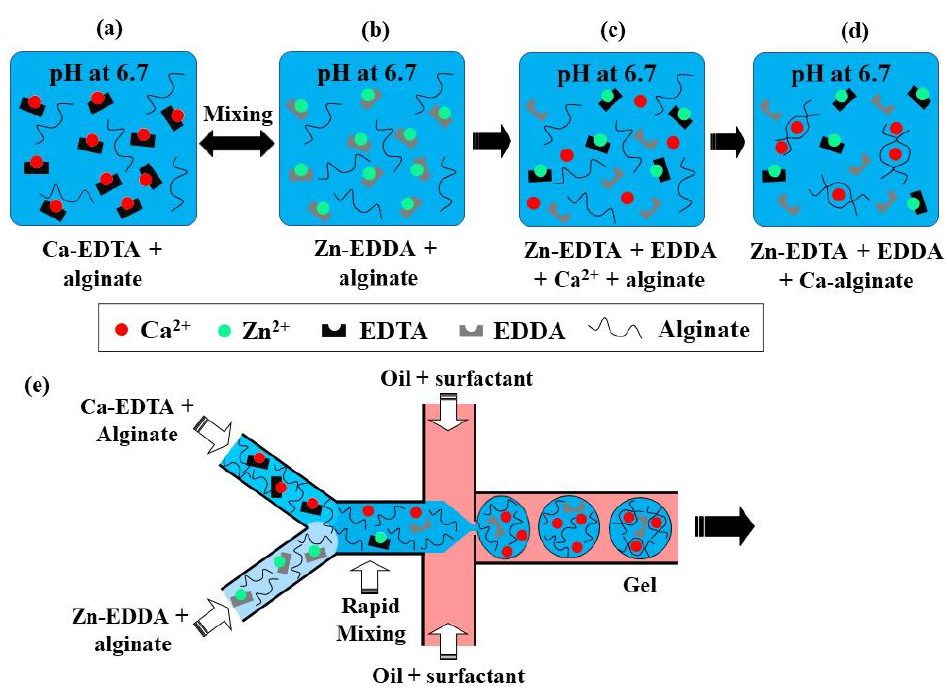
Figure 17. ( a–d ) Crosslinking of alginate by competitive ligand exchange. The Zn 2+ ions are ex- changed between EDDA (ethylenediaminediacetic acid) and EDTA (ethylenediaminetetraacetic acid) because of their difference in affinity, resulting in the release of Ca 2+ ions, which crosslinks the alginate. ( e ) Formation of alginate microgels by CLEX in a microfluidic chip with three inlet streams [37].